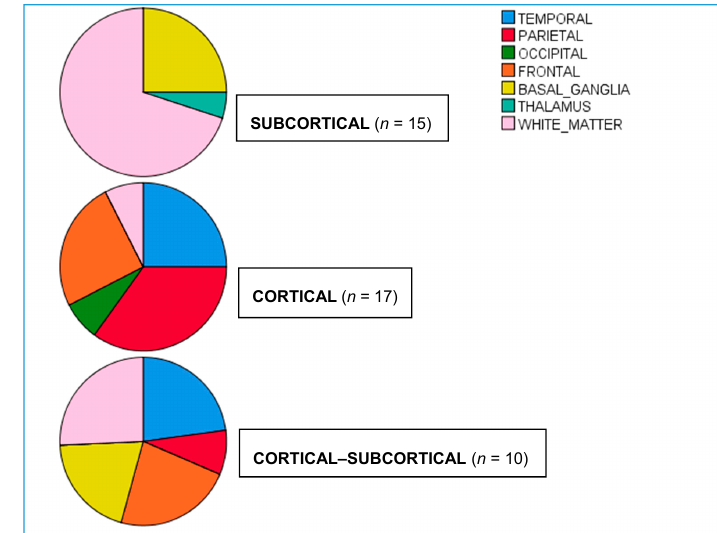
Figure 2. Percent distribution of lesion location for LHD subgroups. Based on the total LHD subgroup (Cortical, Cortical − Subcortical, and Subcortical) with lesion involvement to specific anatomical regions.